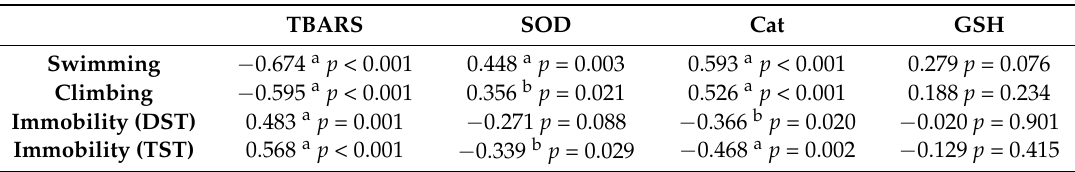
Table 6. Pearson’s linear correlation between the data obtained from antioxidant assays and the data obtained from behavioral tests (DST and TST).